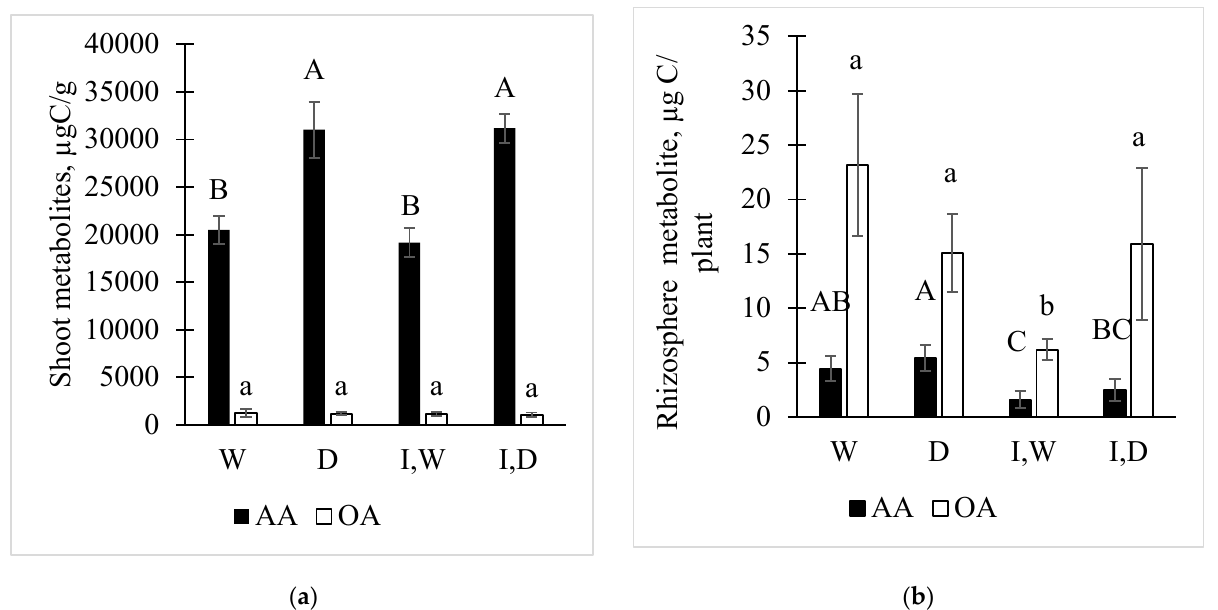
Figure 2. Summed mass of C in amino acids (AA) or organic acids (OA) in ( a ) shoot extracts based on g dry mass shoots or ( b ) the rhizosphere solutions for wheat seedlings grown with four treatments: non-inoculated watered (W) or drought-stressed (D), or Pc O6-inoculated watered (I, W) or drought-stressed (I, D). Each bar is the total of the values averaged from nine independent boxes, and error bars are 95% confidence intervals to illustrate the spread of the data. Bars with different lettering are statistically different within each chemical class by Tukey HSD tests ( p = 0.05). Capital letters cannot be compared to lower-case letters.